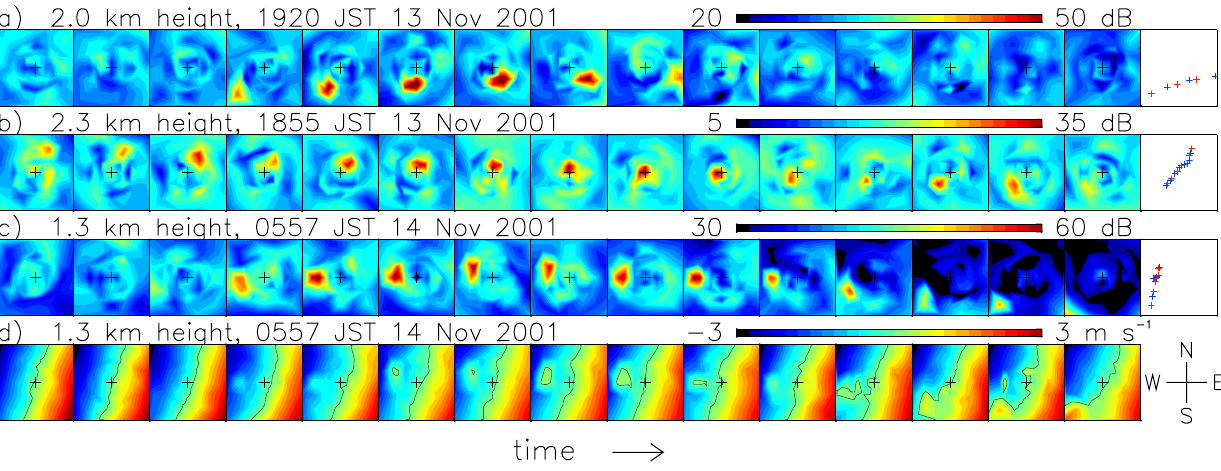
Fig. 10. Horizontal slices of (a)–(c) echo power and (d) line-of-sight velocity for dot echoes moving (a) downwind (b) across and slightly upwind and ( c , d ) changing direction. Widths and time steps are (a) 1000m, 6.55s, (b) 1150m, 6.55s and (c, d) 650m, 13.1s. Last plots in (a)–(c) summarise the dot trajectories. Zero contour is overplotted in